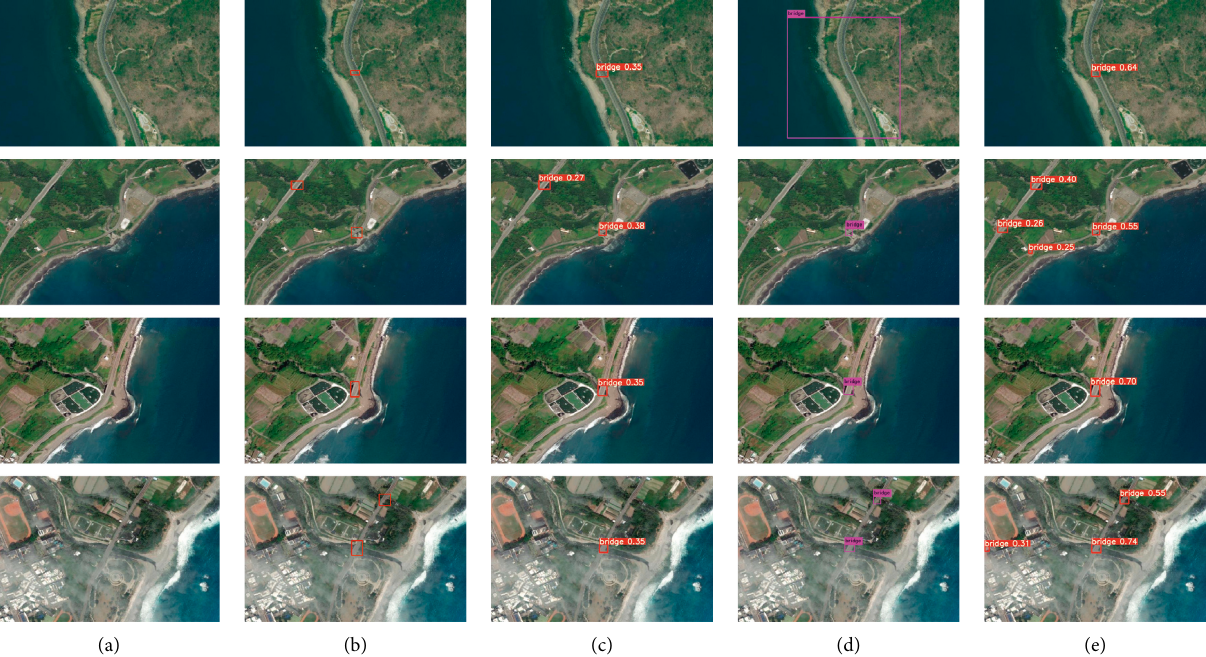
Figure 8: The comparisons of different competing methods for bridge detection at the presence of cooccurrences of water and land. From left to right: (a) original images and detected results by (b) Faster R-CNN, (c) YOLOv3, (d) YOLOv4, and (e) YOLOv5s,